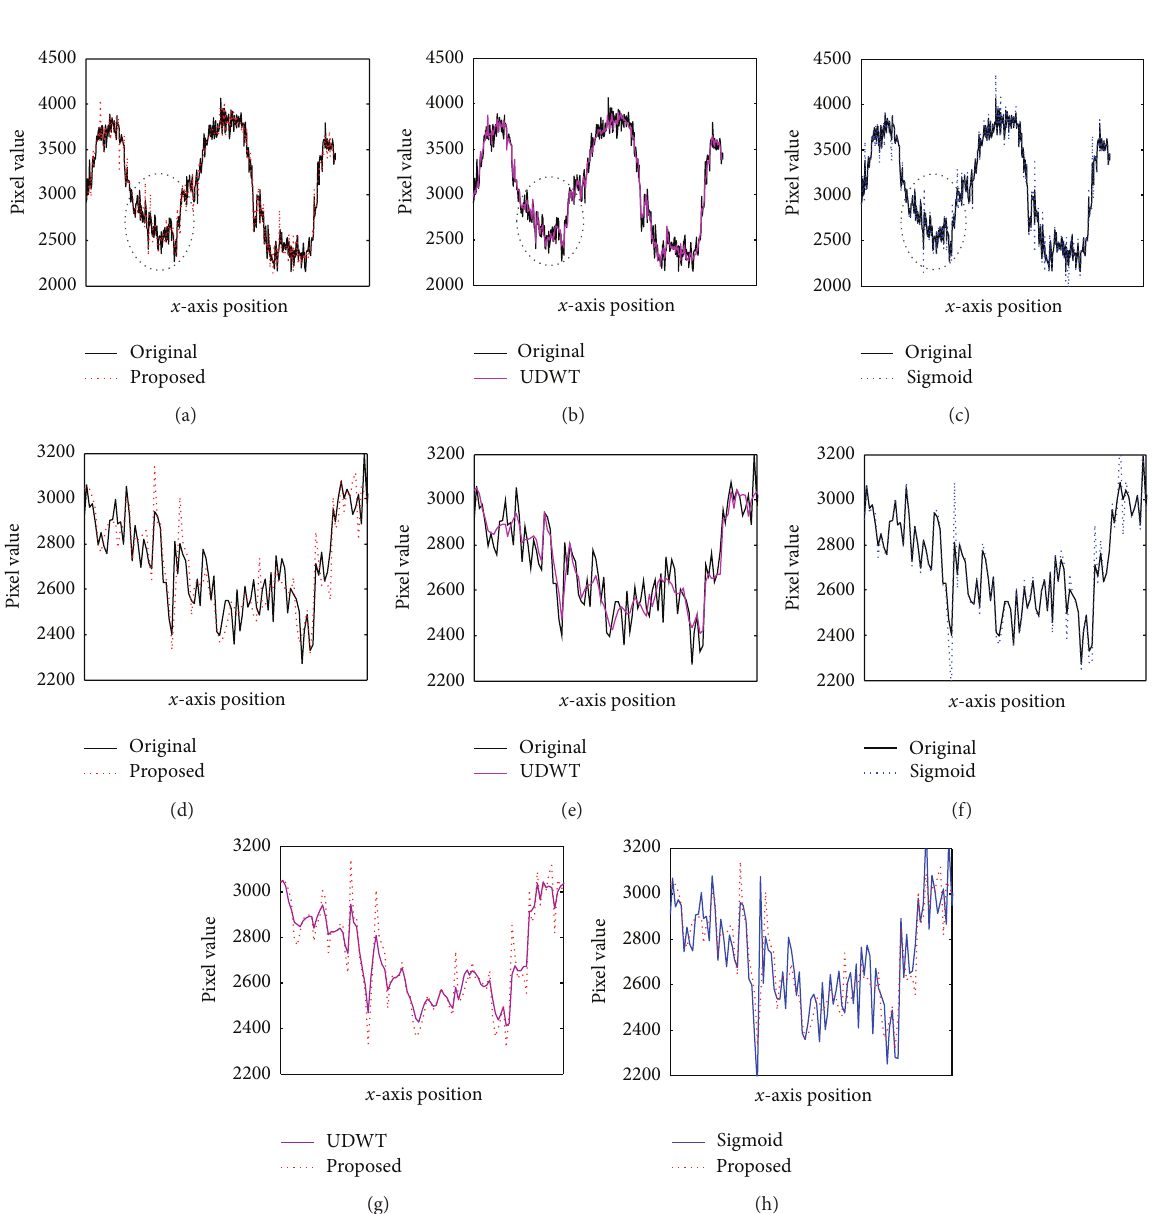
Figure 6: An example showing pixel-value profiles from original and processed chest radiographs. (a)–(c) Original versus processed by the proposed method, the modified UDWT method, and the sigmoid-type wavelet coefficient mapping method, respectively. The profiles were measured along the horizontal lines (black lines) as shown in Figures 5(a)–5(c). (d)–(f) Corresponding magnified profiles indicated by circles as shown in (a)–(c), respectively. (g) Profiles of two processed images; the solid line indicates the profile of an image processed by the modified UDWT method, and the dotted line indicates that by the proposed method. (h) Profiles of two processed images; the solid line indicates the profile of an image processed by the sigmoid-type wavelet coefficient mapping method, and the dotted line indicates that by the proposed